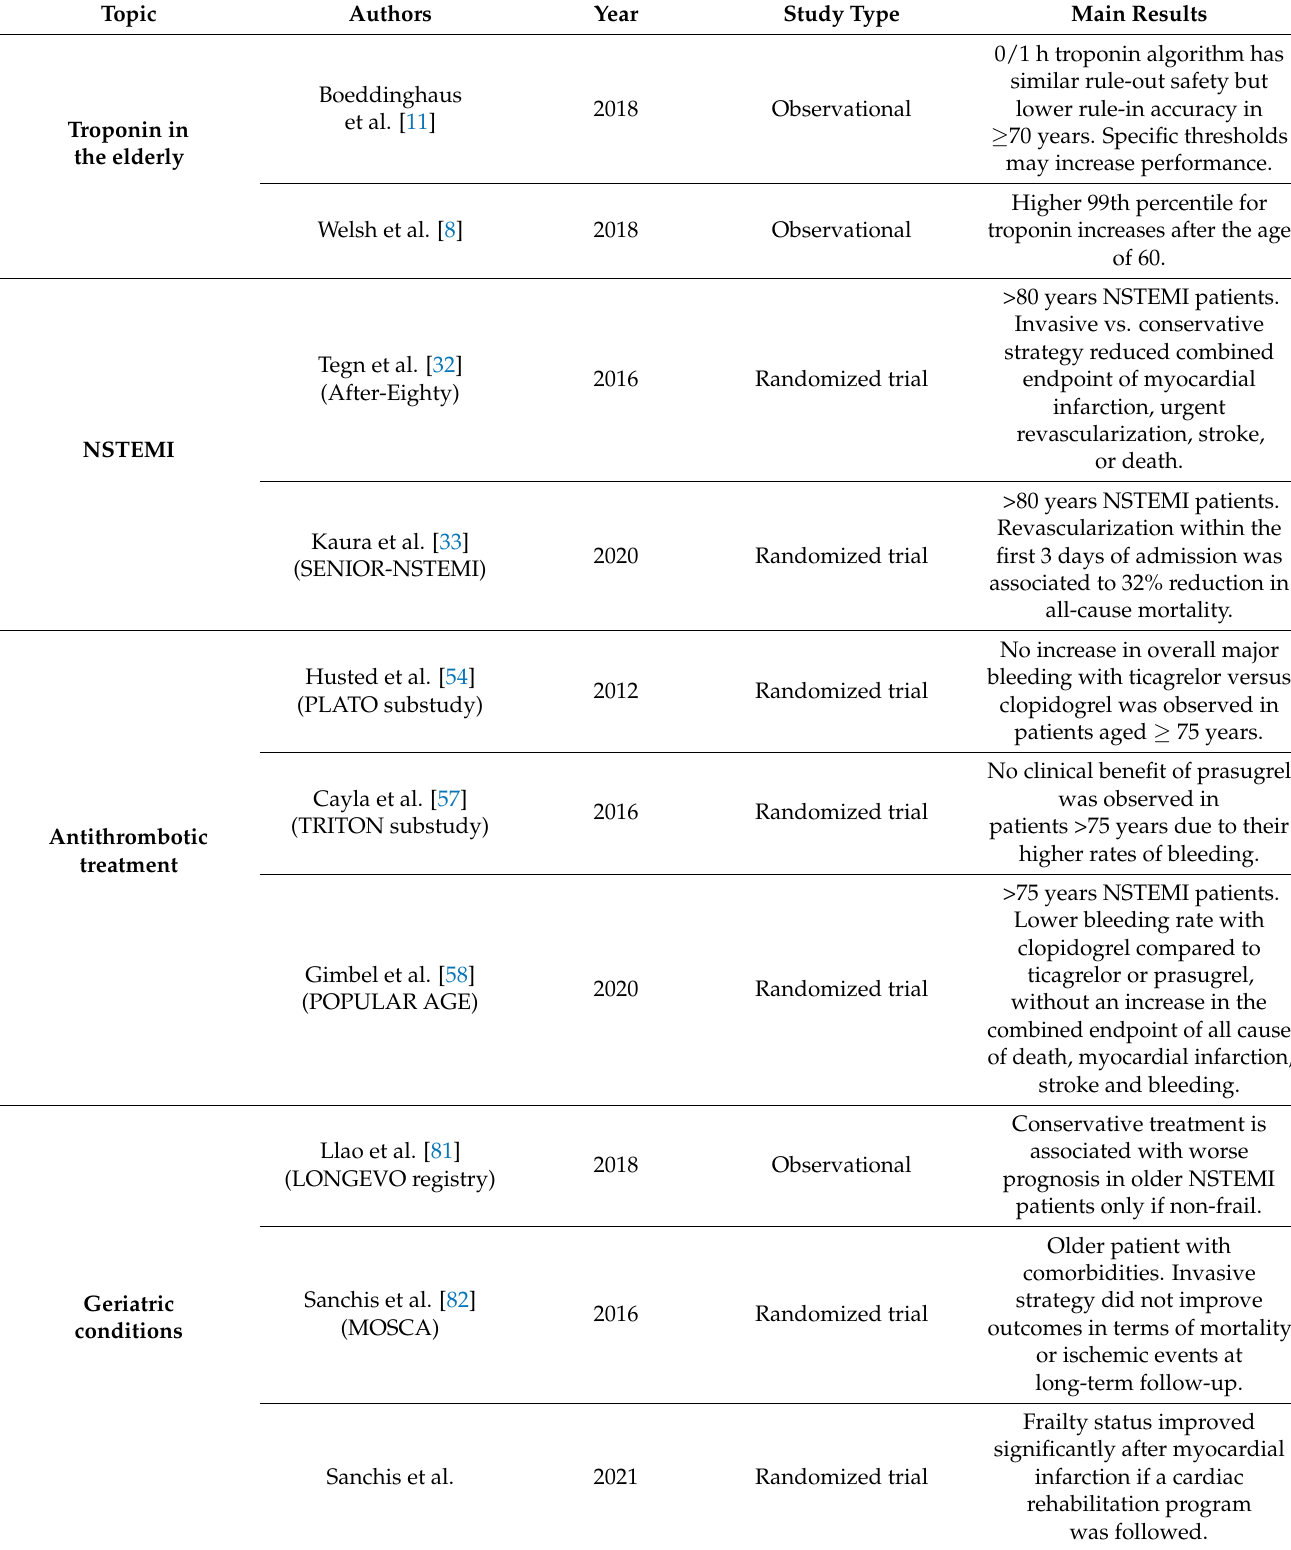
Table 1. A summary of some of the main evidence in ACS in the older